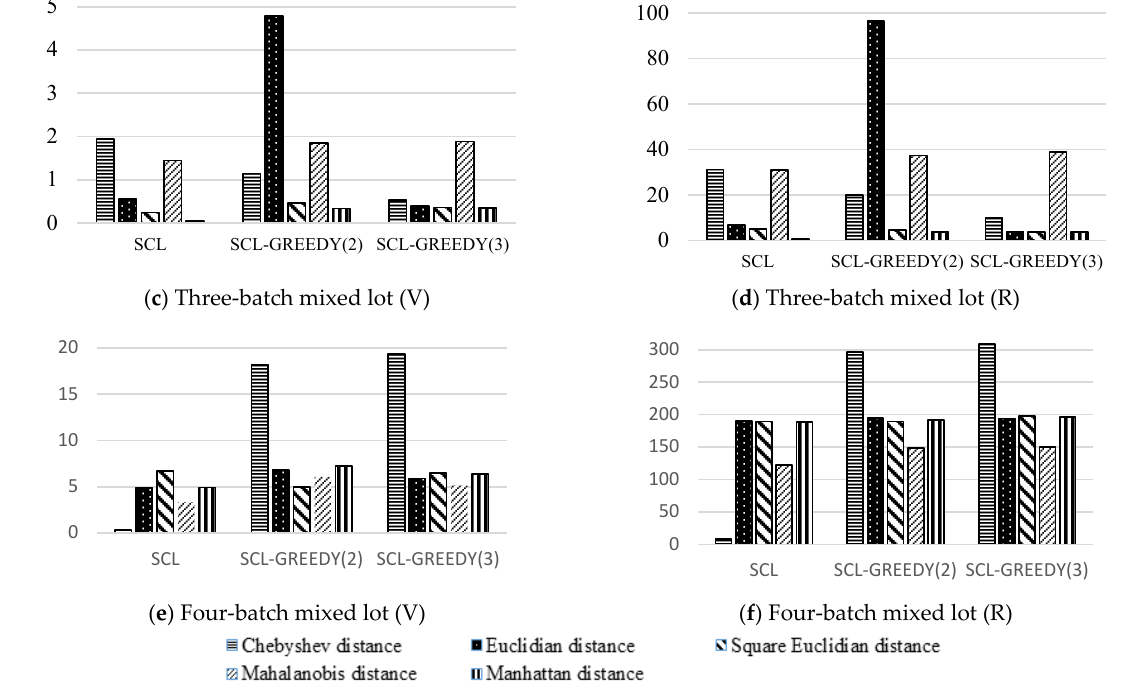
Figure 2. ( a ) Coefficient of variation of the objective function value for two ‐ batch mixed lot; ( b ) span factor of the objective function value for two ‐ batch mixed lot; ( c ) coefficient of variation of the objective function value for three ‐ batch mixed lot; ( d ) span factor of the objective function value for three ‐ batch mixed lot; ( e ) coefficient of variation of the objective function value for four ‐ batch mixed lot; ( f ) span factor of the objective function value for four ‐ batch mixed lot. Table 1. Objective function value summarized after 30 attempts (Chebyshev distance).